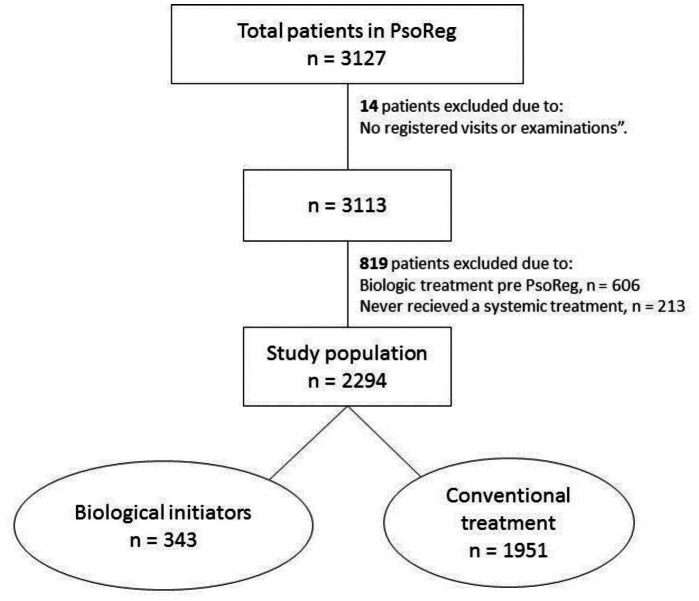
Study population.